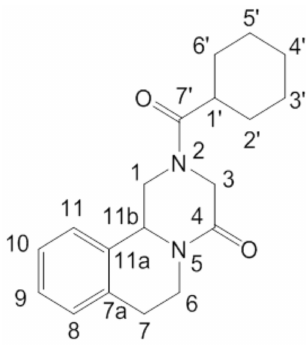
Figure 1. Chemical structure of PZQ ((11bRS)-2-(Cyclohexylcarbonyl)-1,2,3,6,7,11b-hexahydro-4-H- pyrazino[2,1-a]isoquinolin-4-one) with atom